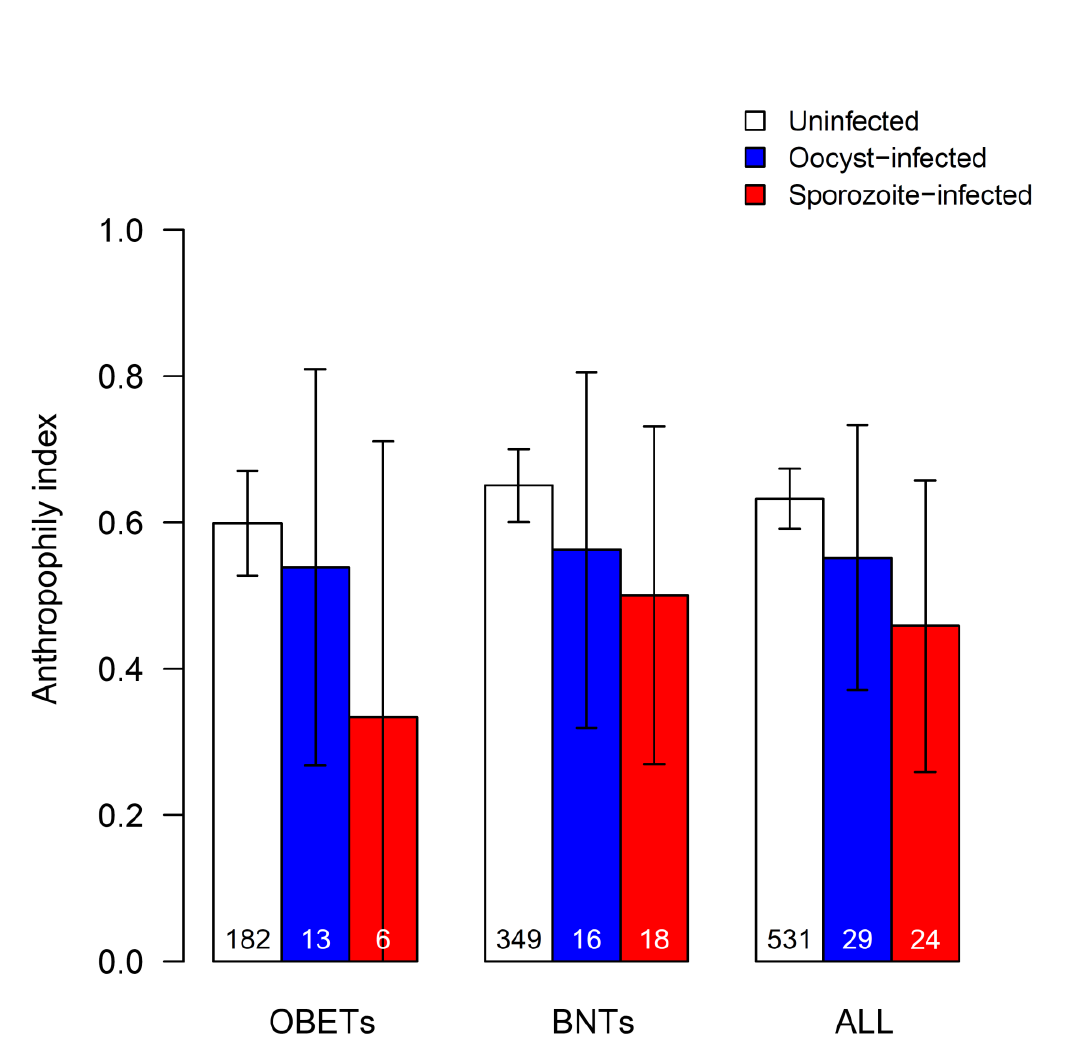
Figure S2. Effect of infection status on the anthropophily index of Anopheles gambiae s. l . females expressed as the proportion of females caught in the human-baited traps out of the total number retrieved from both human- and calf- baited traps. Data show proportion ± 95% confidence interval. Numbers in bars indicate the total numbers of mosquitoes in both